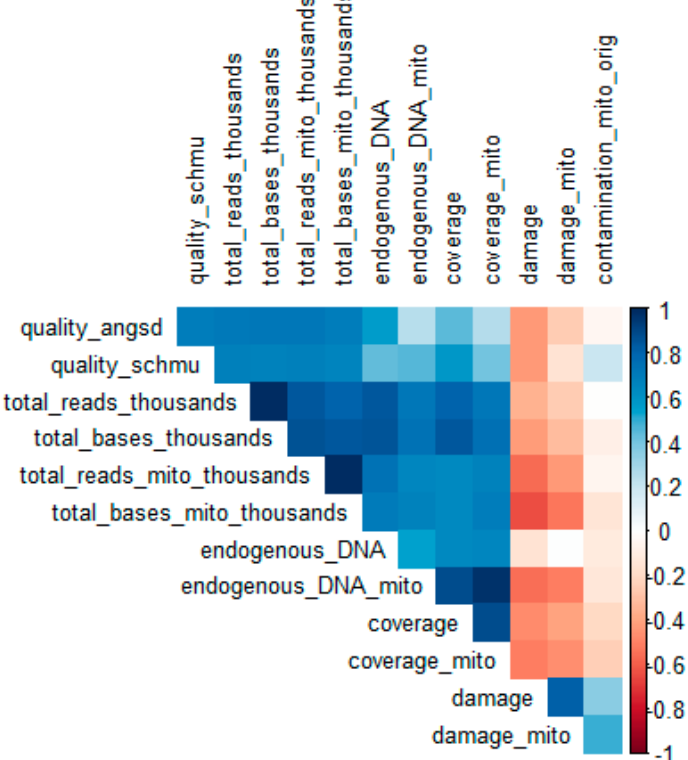
Figure 4. Correlation matrix displaying pairwise correlation coefficients between all sample charac- teristics tested, including the highest overall sample quality achieved during haplogroup prediction, for the newly derived consensus sequences, using the two alternative tools (ANGSD vs. schmutzi). Blue color indicates positive correlation and red color negative correlations. Positive and negative correlation coefficients, on the right-hand side of the plot, similarly indicate the strength of associa- tions. The deeper the color the stronger the correlation. Scatter plots for the strongest correlations between predictors and overall sample quality can be found in Figure S3.